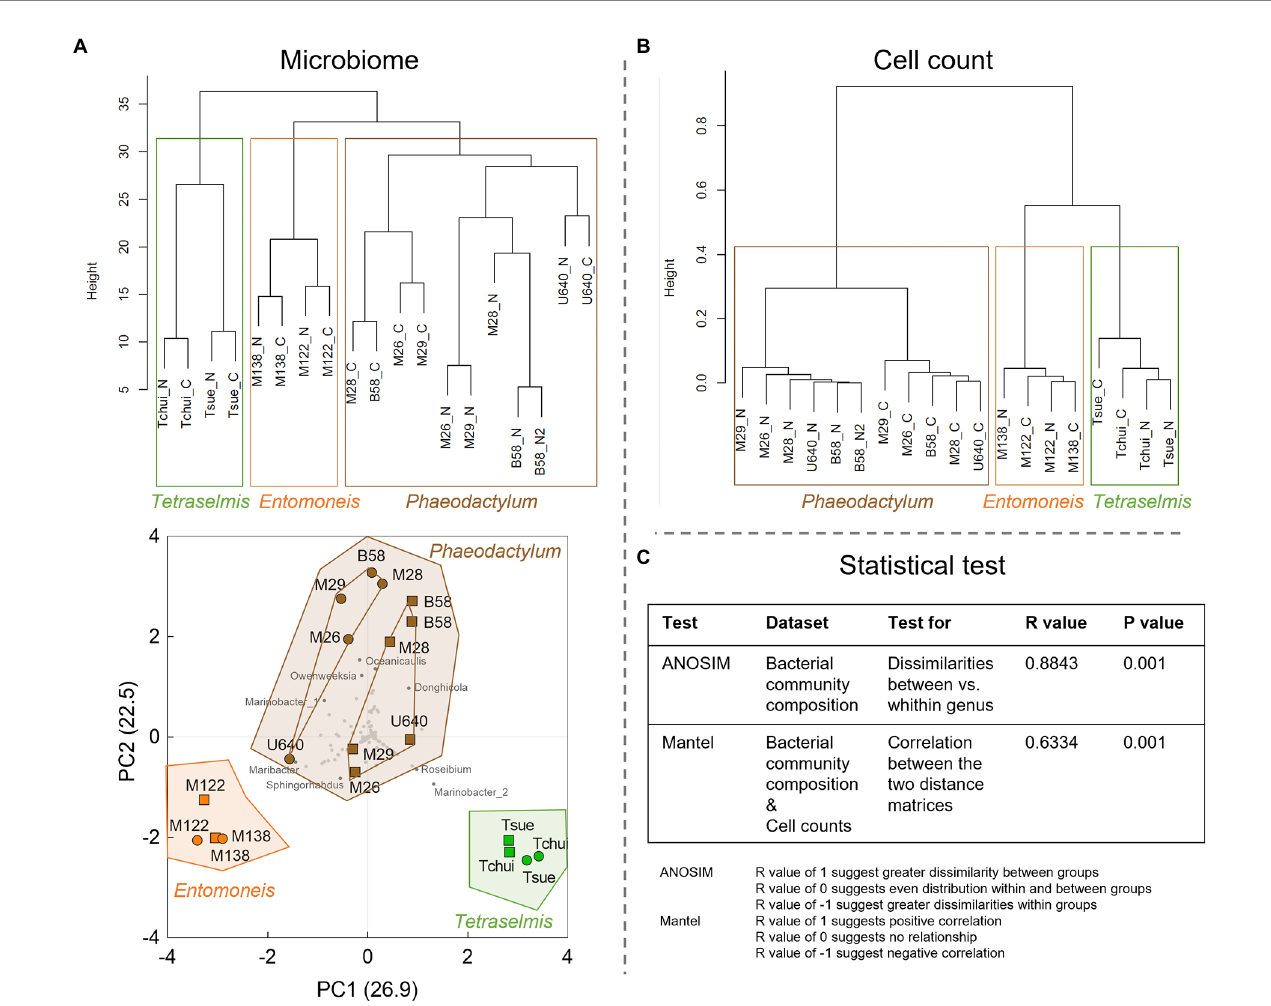
FIGURE 5 Statistical analysis of the microbiome and cell count data from the stock culture screening. (A) Dendrogram (upper) and principal component analysis (PCA, lower) of the normalized bacterial community composition data. All sequenced OTUs were included in the calculations and are shown as gray dots in the PCA plot, and OTUs with largest impact are shown as dark gray dots with bacterial genus name. In the dendrogram, N stands for NORCE and C for Conway medium. In the PCA plot, circles indicate Conway and squares NORCE medium. For Phaeodactylum stock cultures inner connecting lines indicate two distinct subclusters defined by culture medium (Conway or NORCE). (B) Hierarchical dendrogram of the cell count data (microalgae and bacteria). (C) Statistical tests with R and p